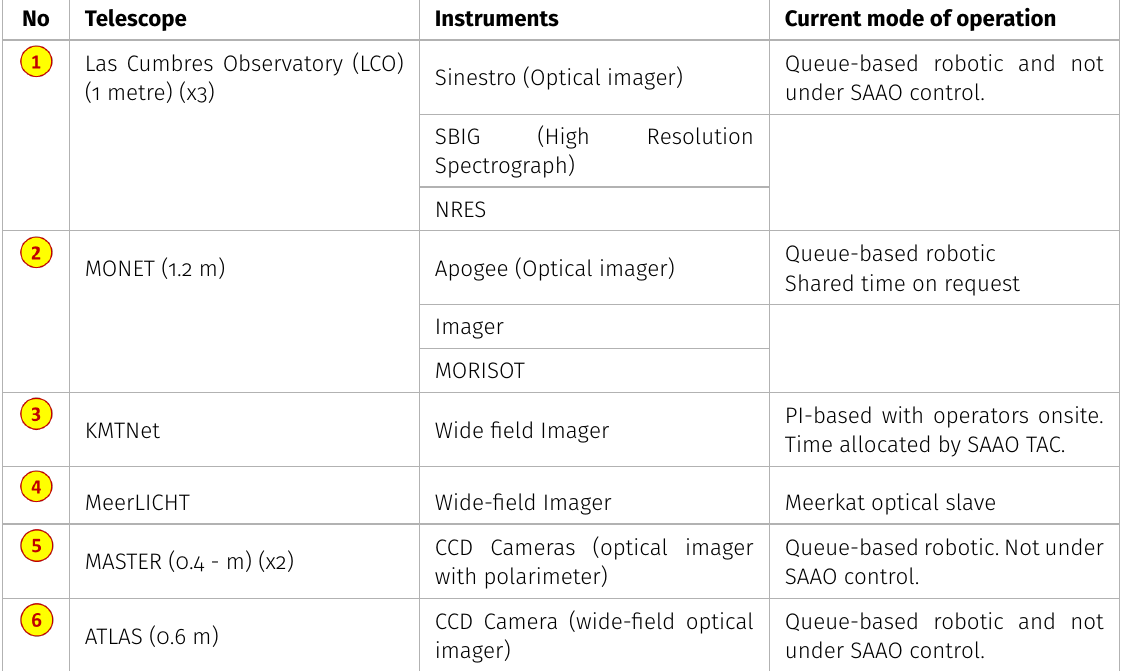
Table I. Sutherland hosted facilities and mode of